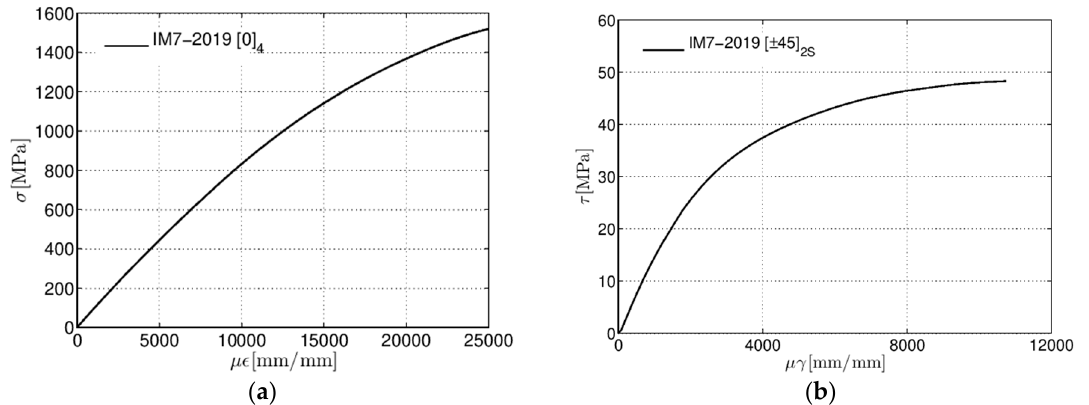
Figure 6. Tensile stress-strain curves for IM7-2019 composite ( a ) unidirectional (UD) [0] 4 and ( b ) [±45] 2S . ( b ) [ ± 45] 2S